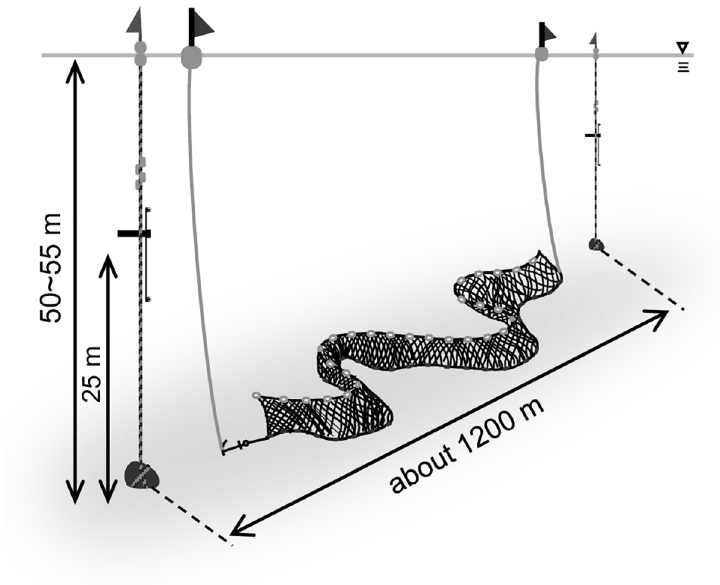
Fig 1. Illustration of the A-tag and bottom-gillnet set-up monitored off Rausu, Hokkaido, Japan.